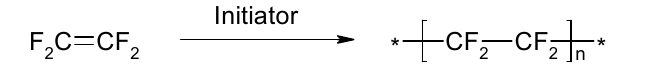
Figure 1. The polymerization of